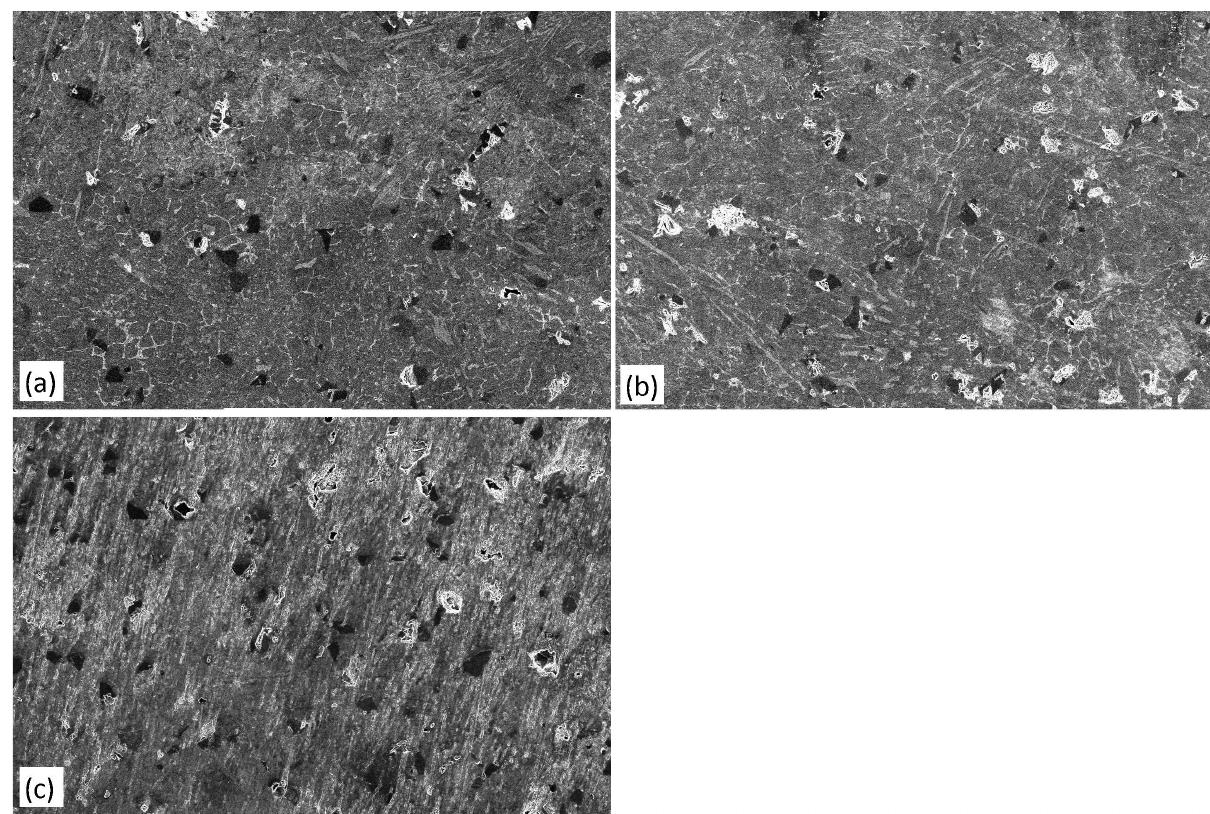
Fig. 10: SEM images of microstructures of the composites of the 6% SiC reinforced composites manufactured at 800 °C and 500 rev/min stirring speed, in (a) 2, (b) 4 and (c) 6